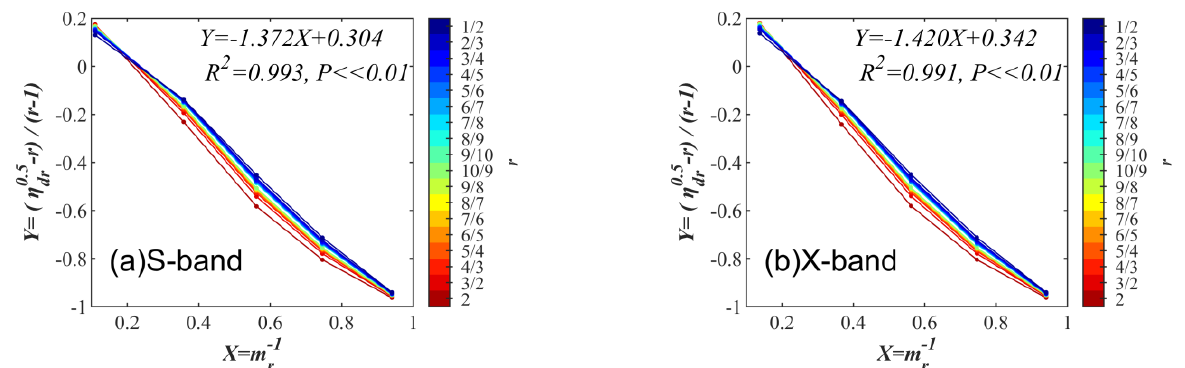
Figure 3. Variation of η dr with m r −1 for a single ellipsoidal water particle with different axial ratios (colors of the lines) when D =1 mm. ( a ) S-band, ( b ) X-band.